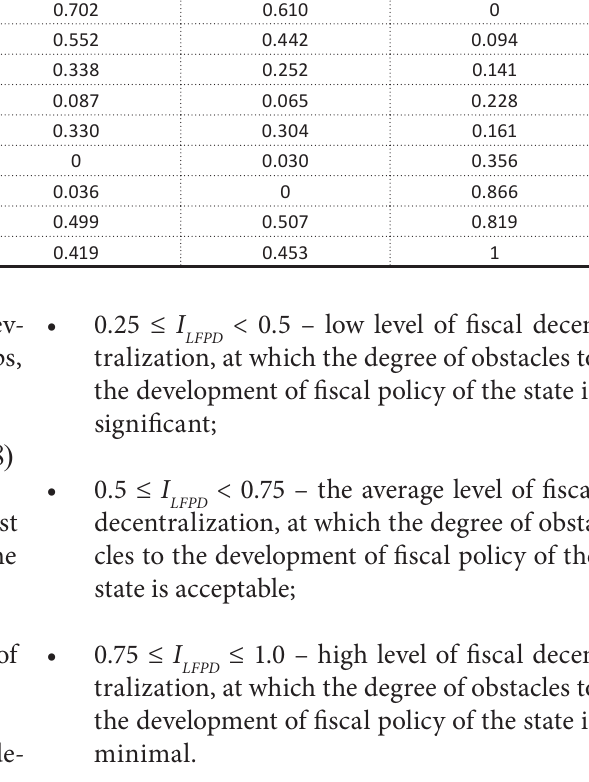
Table 14. Sub-index equation and integral indicator of the level of fiscal decentralization